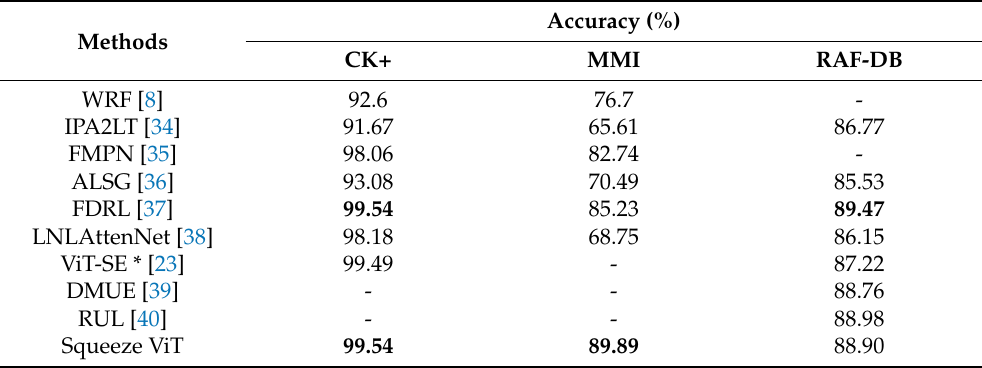
Table 3. Performance comparison with state-of-the-art methods applied to the CK+, MMI, and RAF-DB datasets. Bold marks the best